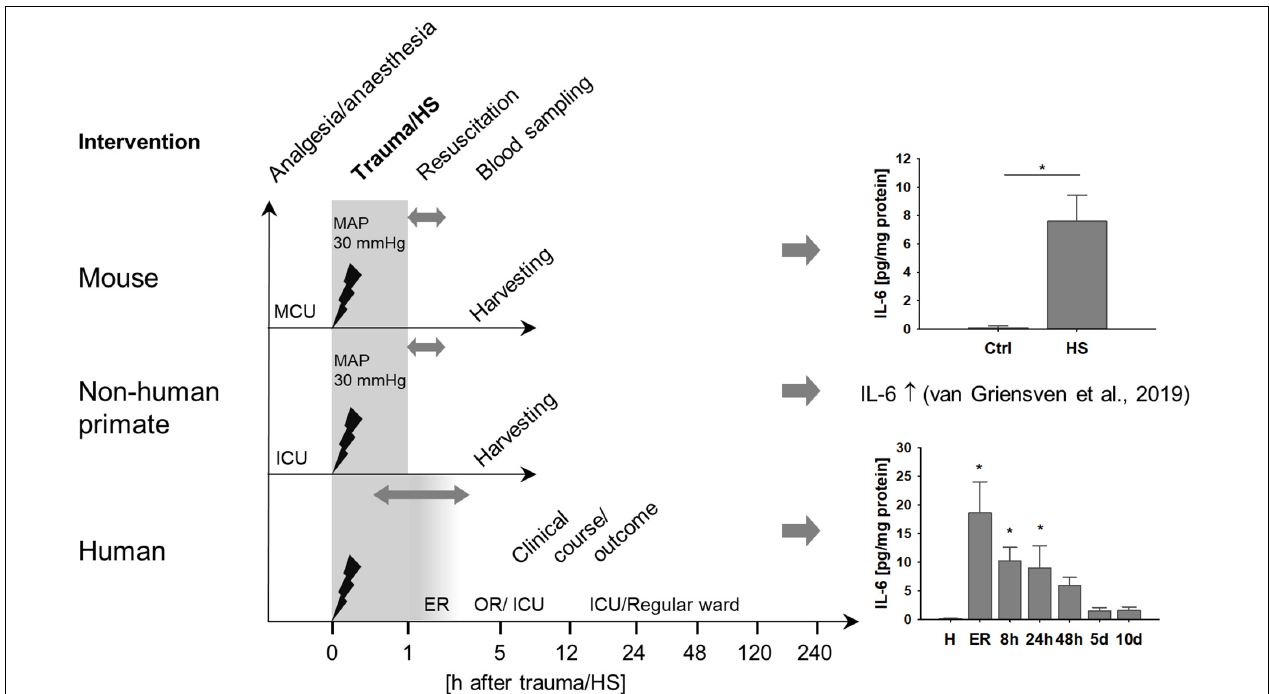
FIGURE 1 | Systemic inflammation induced by hemorrhagic shock (HS) across various species. Mice and non-human primates were anesthetized and underwent severe hemorrhage at a mean arterial pressure (MAP) of 30 mmHg for 60 min. After resuscitation with crystalloids, animals were monitored until organ harvesting 5 h after shock induction. Mice demonstrated significantly increased plasma interleukin 6 (IL-6) after HS compared to healthy controls (ctrl). * p < 0.05, n = 4 ctrl, and n = 8 HS. As has been described elsewhere, HS in non-human primates induced a pronounced systemic pro-inflammatory response reflected by significantly increased plasma IL-6 (13). In a clinical prospective observational study, severely injured patients were monitored beginning upon arrival at the emergency room (ER) at fixed time intervals until day 10 after injury. Similar to mice and non-human primates, patients demonstrated distinct increases in plasma IL-6, especially during the first 24 h after trauma. * p < 0.05 vs healthy (H), n = 8 healthy, n = 11–13 polytrauma patients; ER, emergency room; ICU, intensive care unit; MCU, mouse intensive care unit; OR, operating